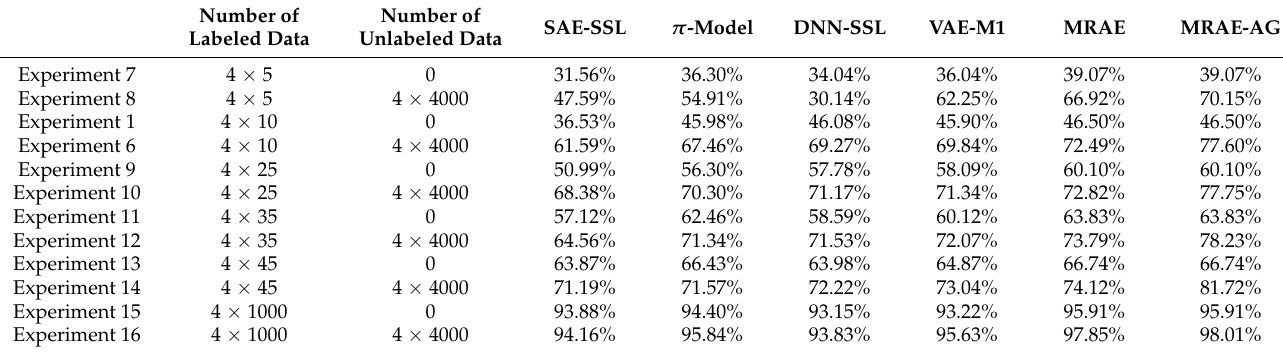
Table 5. Fault diagnosis results of experiments 7–16.